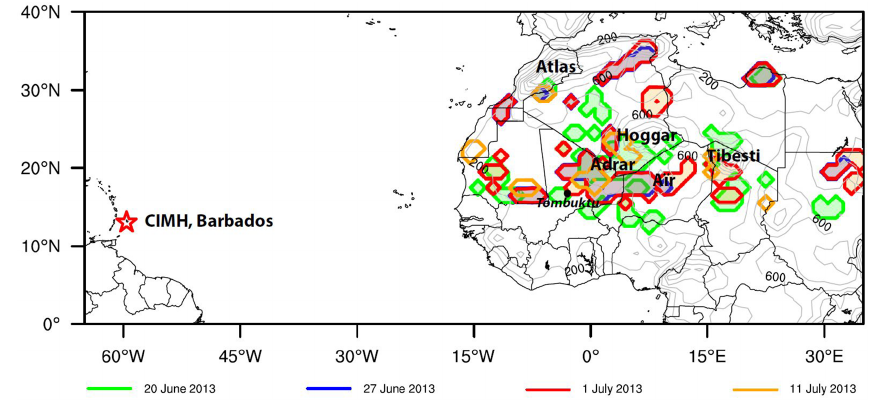
Figure 3. Active dust sources relevant for the four investigated case studies. The colors indicate which source region contributed to which dust event observed over Barbados.